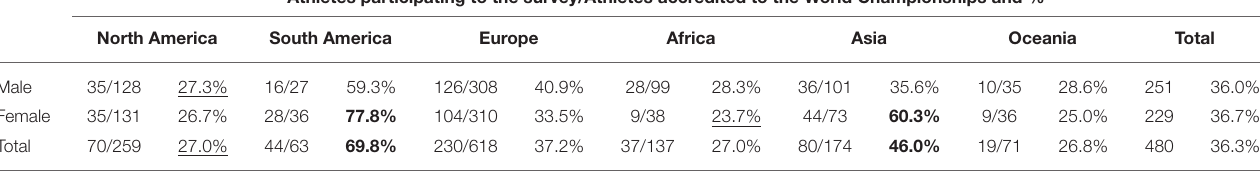
TABLE 1 | Proportion of athletes participating to the study, displayed by sex, and geographical area. Athletes participating to the survey/Athletes accredited to the World Championships and % North America South America